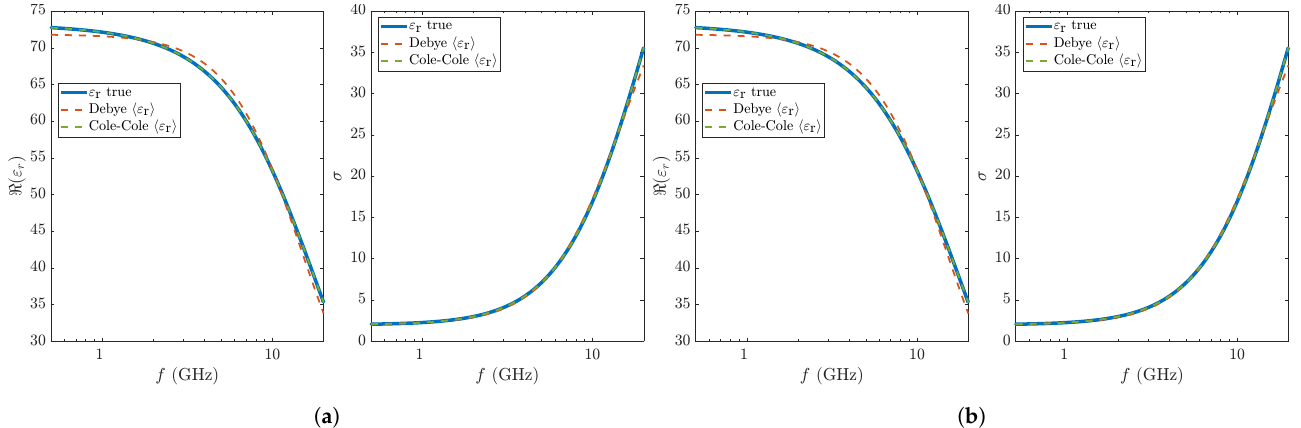
Figure 1. Real part of relative permittivity and conductivity of synthetic data (100 mg/dL glucose concentration) and Debye’s and Cole–Cole’s fitted curves. LMA ( a ) and VPA ( b ) with Set A of initial points are used.